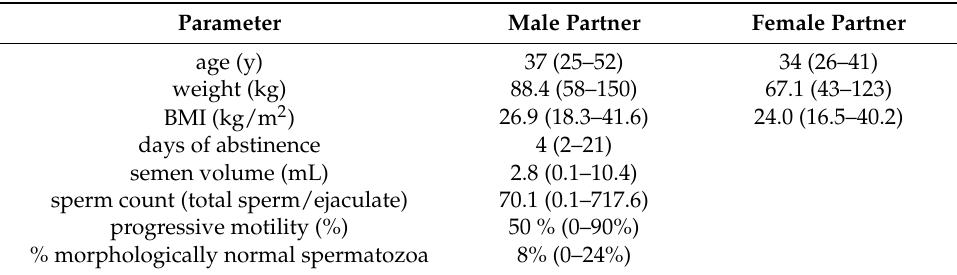
Table 2. Demographical and clinical data on the patients’ cohort. The minimal and maximal values are given in brackets.